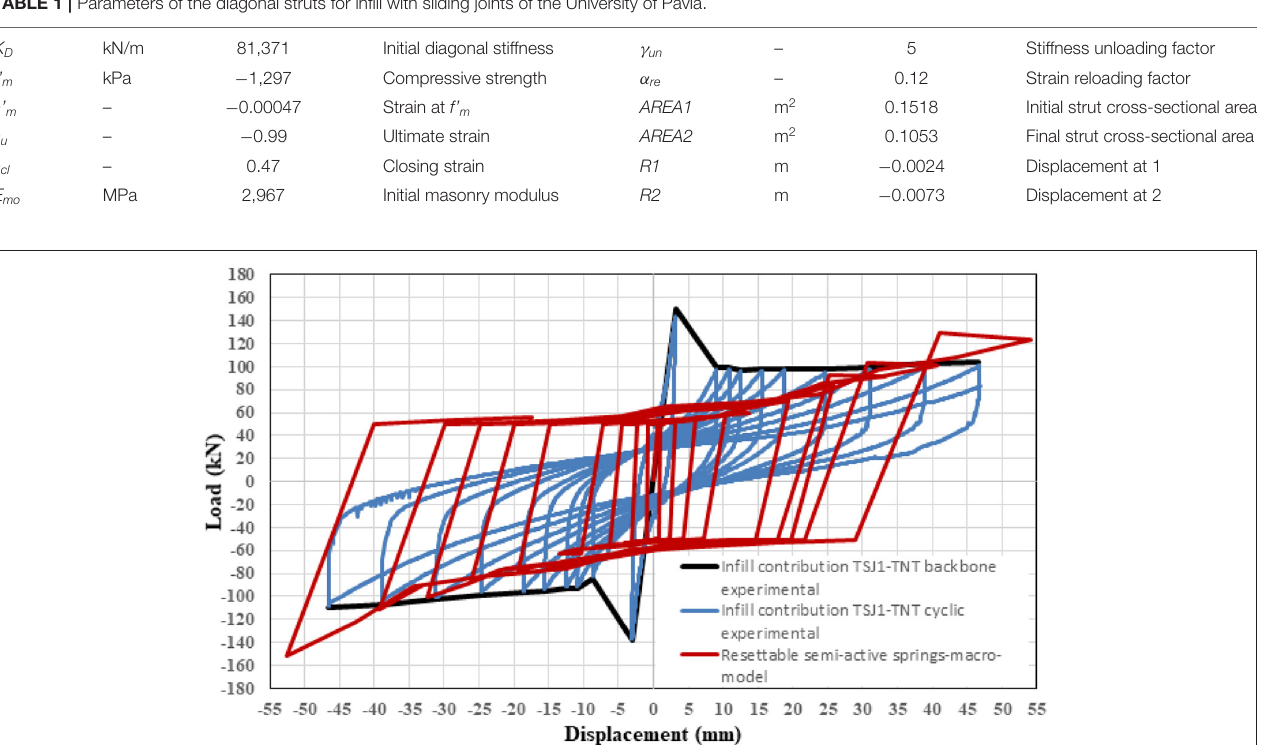
TABLE 1 | Parameters of the diagonal struts for infill with sliding joints of the University of Pavia.